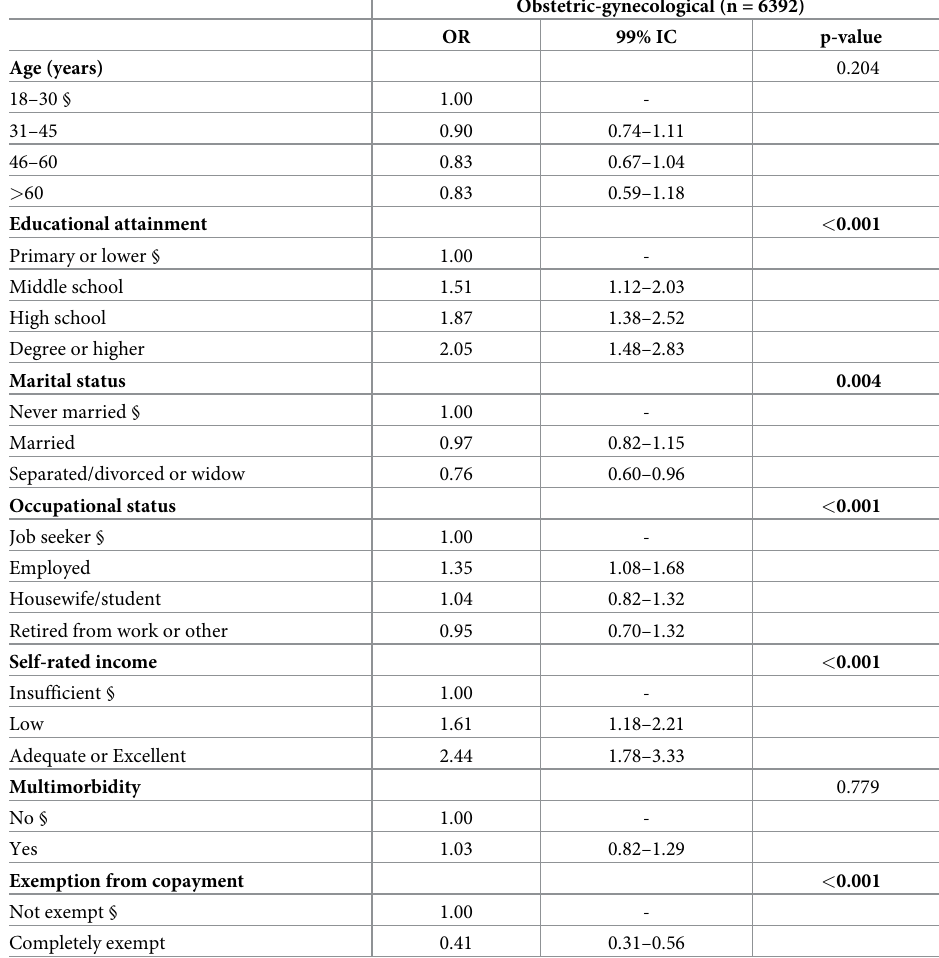
Table 3. Factors predisposing to the use of private services for obstetric-gynecological visits: Results of multivari- able logistic regression